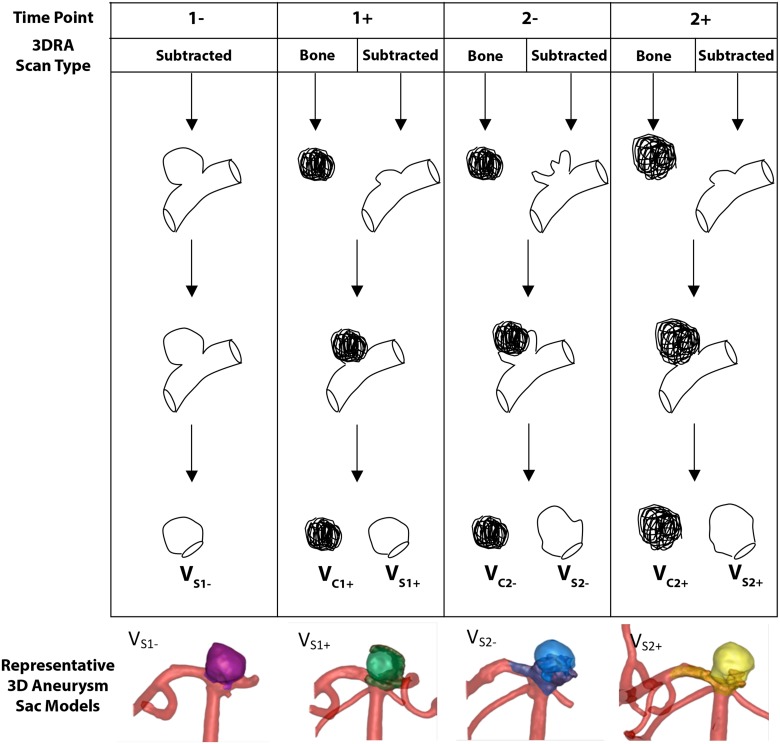
Schematic illustration of the image processing protocol.‘1- ‘ indicates the pre-first coiling treatment time point; ‘1+’, post-first coiling treatment time point; ‘2-’, pre-second coiling treatment time point; ‘2+’, post-second coiling treatment time point; 3DRA, 3D rotational angiogram. The first column depicts the image processing protocol for the 1- time point, beginning with generation of the aneurysm and vessel model from the subtracted 3DRA scan. The aneurysm sac is then automatically isolated from the vasculature. A representative 1- aneurysm sac model is shown at the bottom of column 1. The adjacent column details the workflow for analyzing the data from the 1+ time point. At this time point the coil mass model is generated from the baseline (or bone) 3DRA scan, while the vessel and residual blood model is generated from the subtracted angiographic scan. The coil mass, vessel and residual blood models are then added together by Boolean union. The aneurysm sac is the combination of the coil mass and any outlying residual blood, of which the aneurysm neck surface is automatically determined. A representative 1+ aneurysm sac model is shown at the bottom of column 2. The remaining two columns outline a similar workflow for analyzing data from the 2- and 2+ time points respectively.